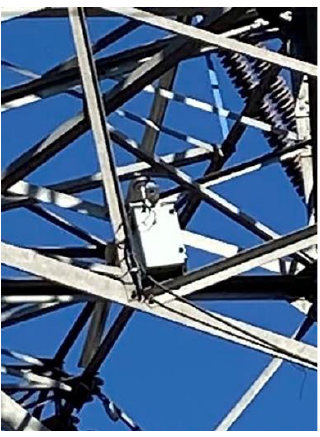
Figure 11. Measurement equipment around thermal power